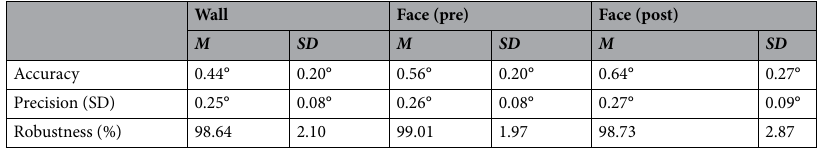
Table 1. Accuracy, precision and robustness for the calibration validations wall , face (pre) and face (post) . Mean ( M ) and standard deviation ( SD ) for eye-tracking quality are shown for all three points of measurements (wall, face pre, face post). Robustness is reported in percent, accuracy and precision in visual angle. Precision (SD): precision calculated as standard deviation of the data sample. Of the 1734 trails, 34 markers (1.96%) had to be corrected because of saccades. 70 markers (4.04%) had to be postponed due to suboptimal marker time setting. 9 trails (0.52%) had to be excluded due to experimenter error. 13 trails (0.75%) had to be excluded because of robustness <